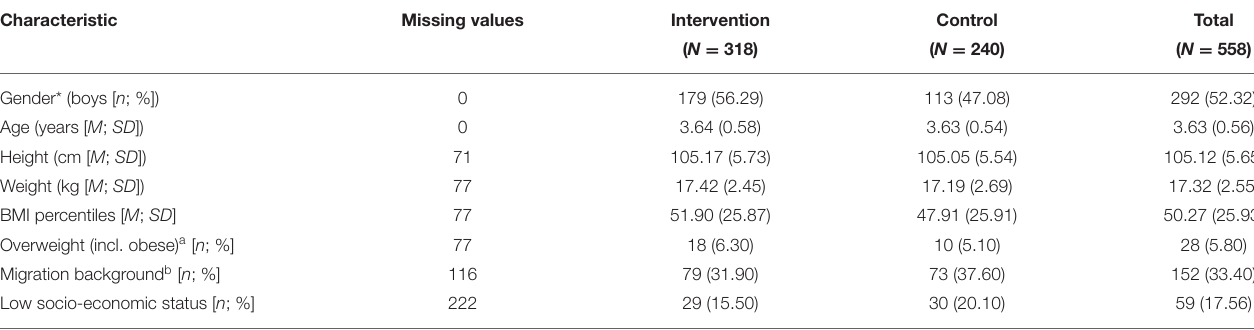
TABLE 1 | Sample description baseline (children with participation at baseline and follow-up). Characteristic Missing values Intervention